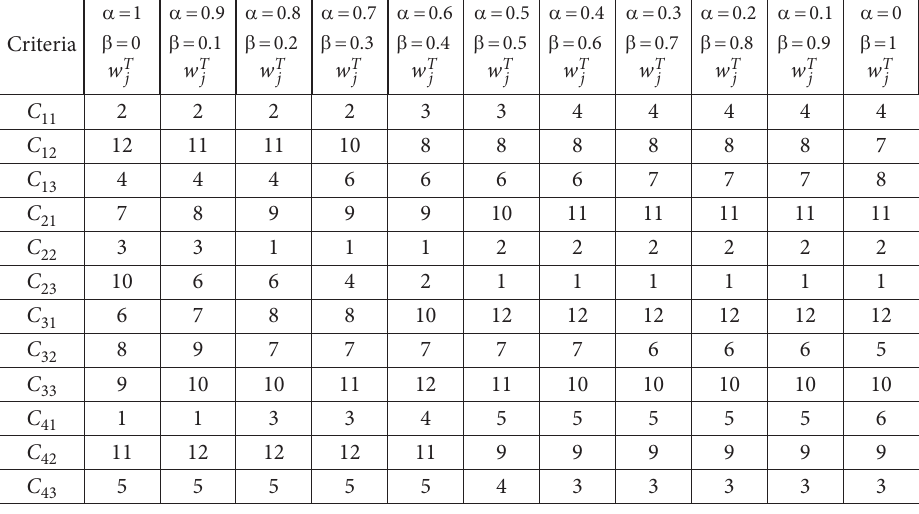
( ) T w ranking as per variation in coefficient values j